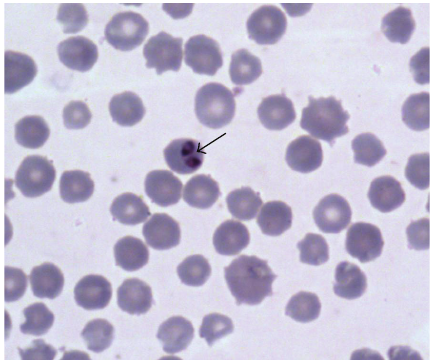
Figure 2: Shows detection Babesia spp. in bushbuck ( Tragelaphus scriptus